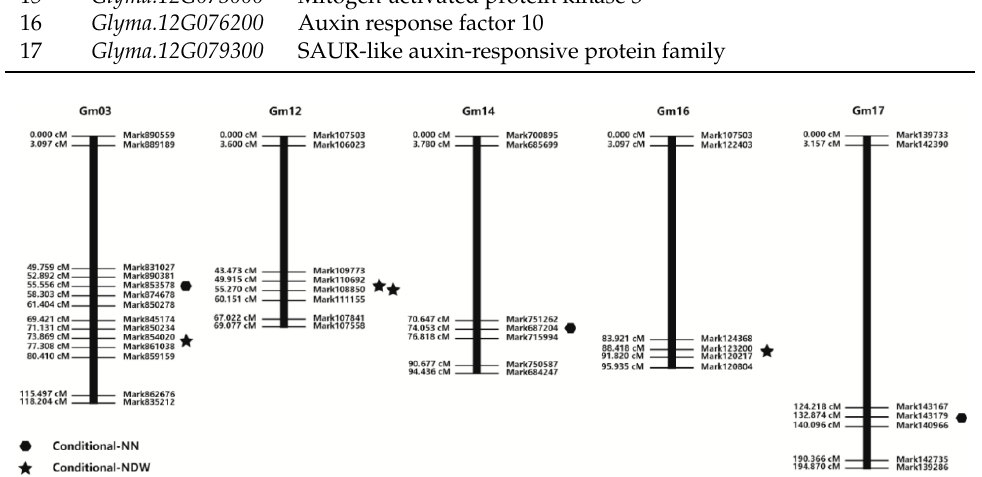
Figure 2. Chromosomal QTL locations of regions associated with the nodule traits of soybean. No overlapping QTLs were detected for NN and NDW, although two QTLs located on Gm12